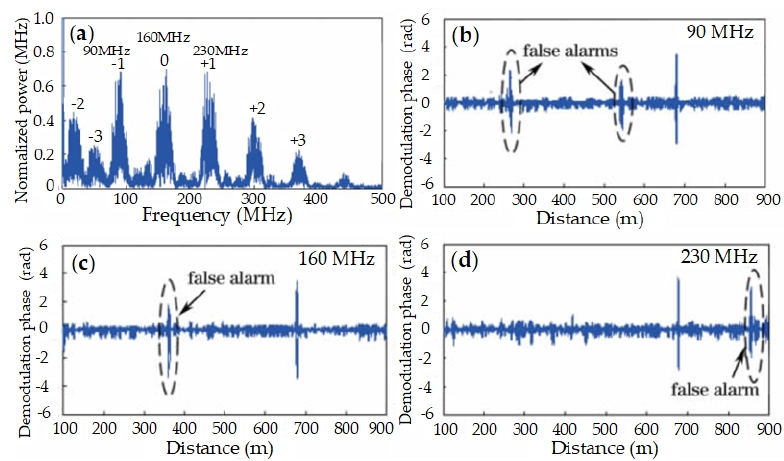
Figure 6. Experimental results. ( a ) Frequency spectrum of beating signals; Demodulation results with different laser frequencies: ( b ) 90 MHz, ( c ) 160 MHz and ( d ) 230 MHz. Reproduced from our previous paper [62].